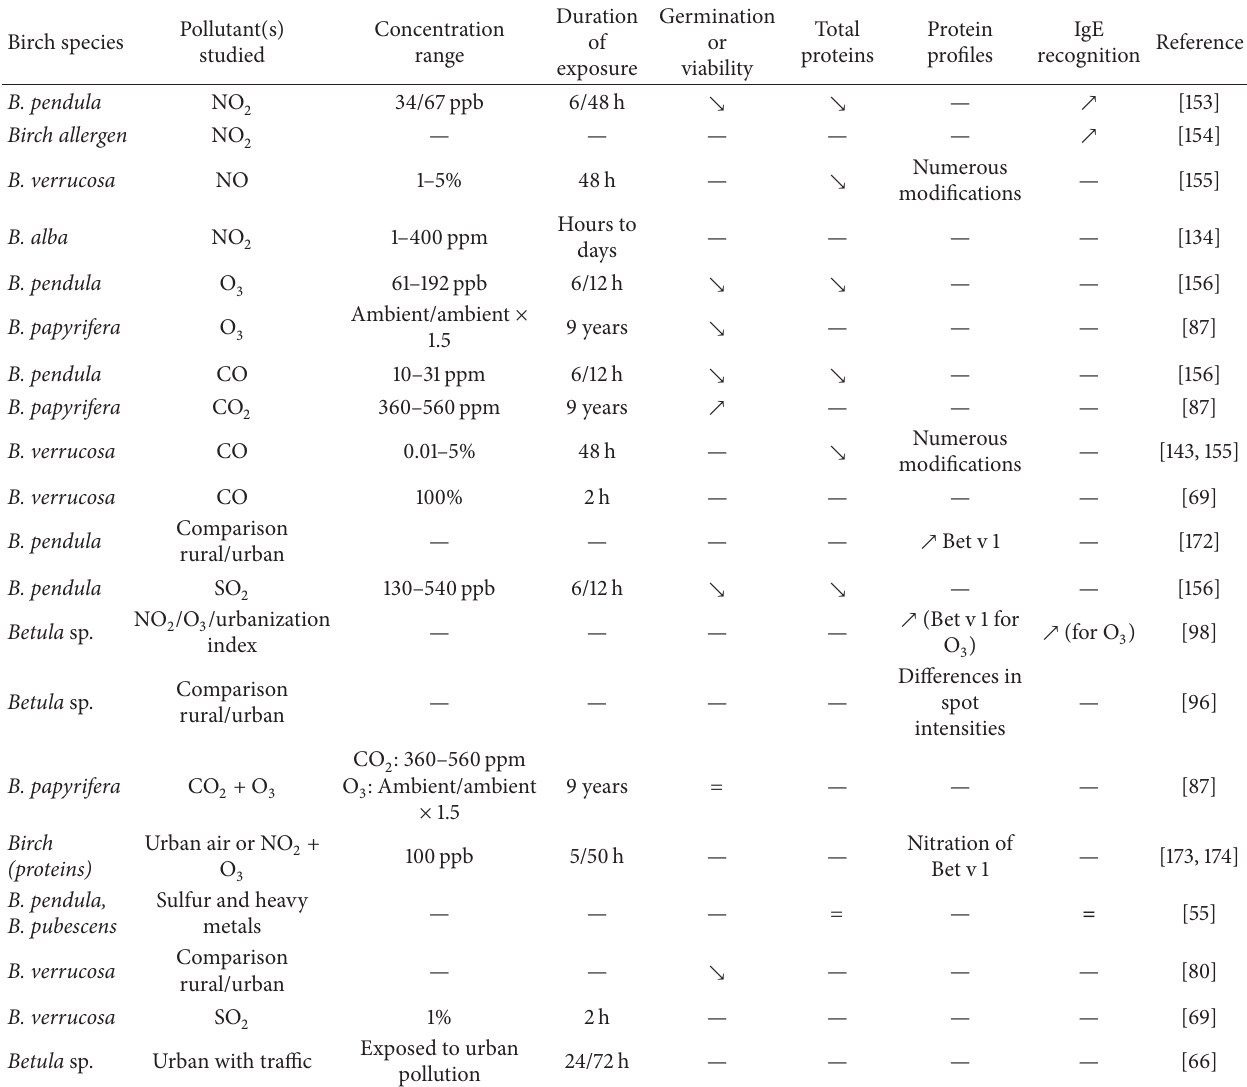
Table 1: Studies of the effect of different air pollutants on birch pollen